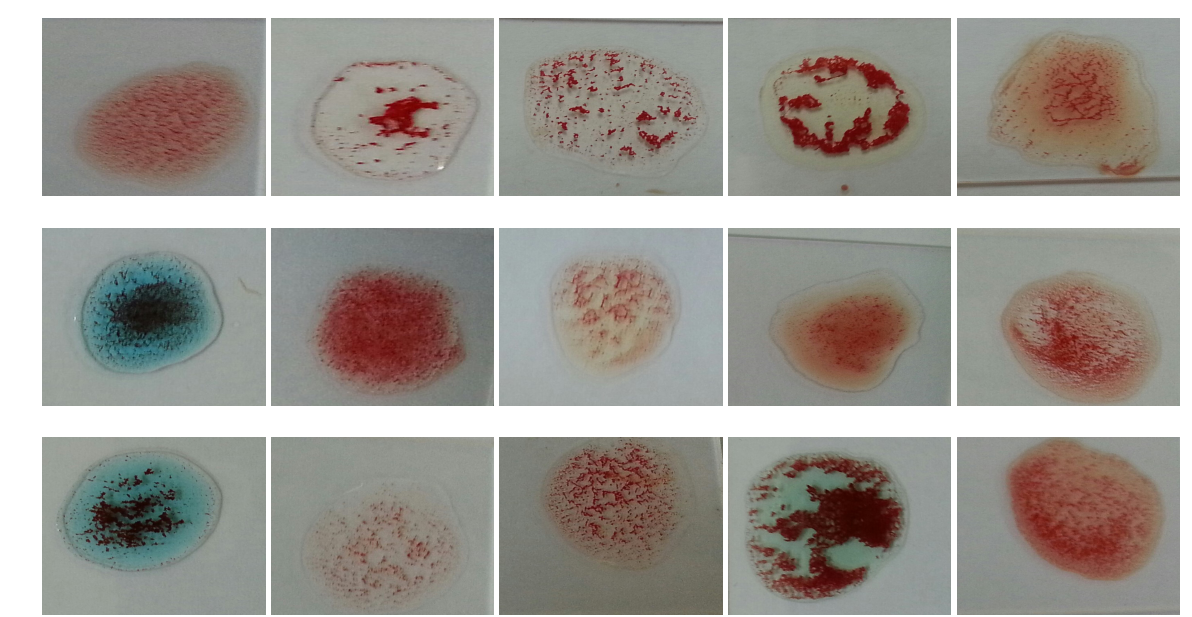
Figure 7. Samples with different agglutination